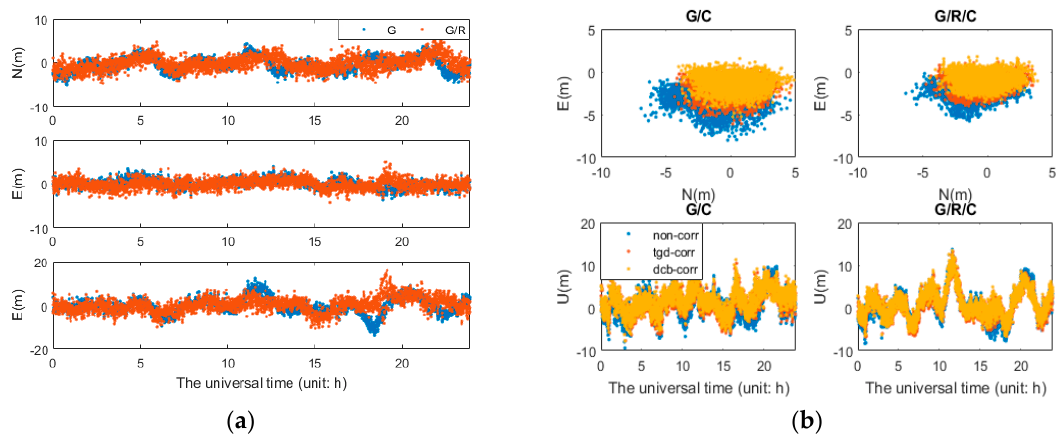
Figure 5. Positioning error series of b1b2 SPP in multi- constellation combinations: ( a ) description of GPS and GPS/GLONASS combinations; and ( b ) description of GPS/BDS and GPS/GLONASS/BDS combinations.